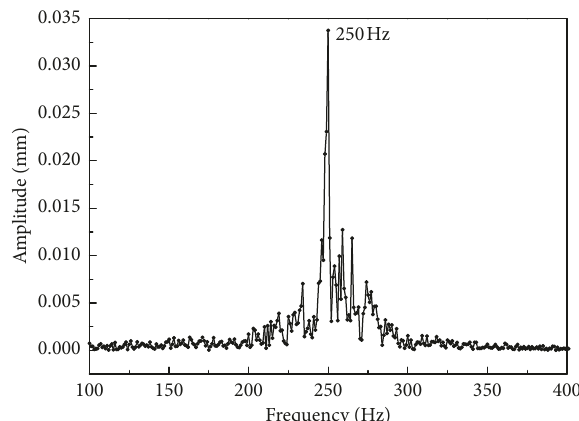
Figure 5: Frequency-domain response of the tip at the rotating speed 5000rpm.